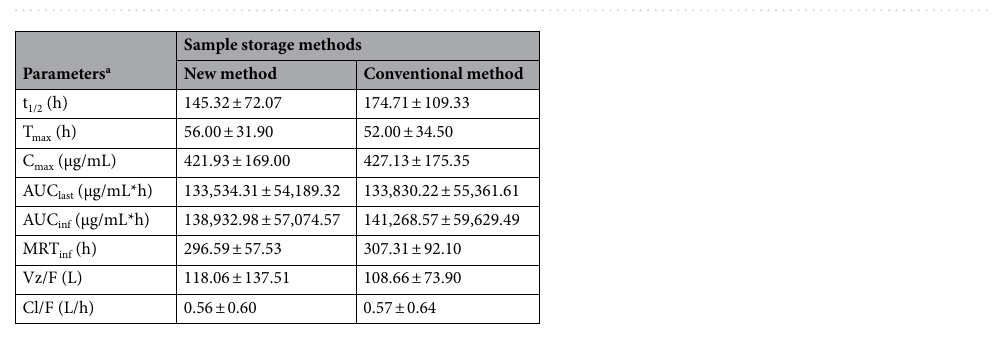
Table 5. The PK parameters of etanercept for six healthy volunteers after they receive one subcutaneous injection of 50 mg etanercept. a Each parameter was performed with a variance test, and the P value was bigger than